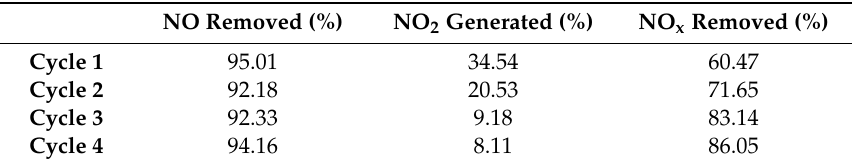
Table 4. Percentages of NO removed, NO 2 generated, and NO x removed for 4 reuse cycles of Pd-I and 5 h of UV-vis